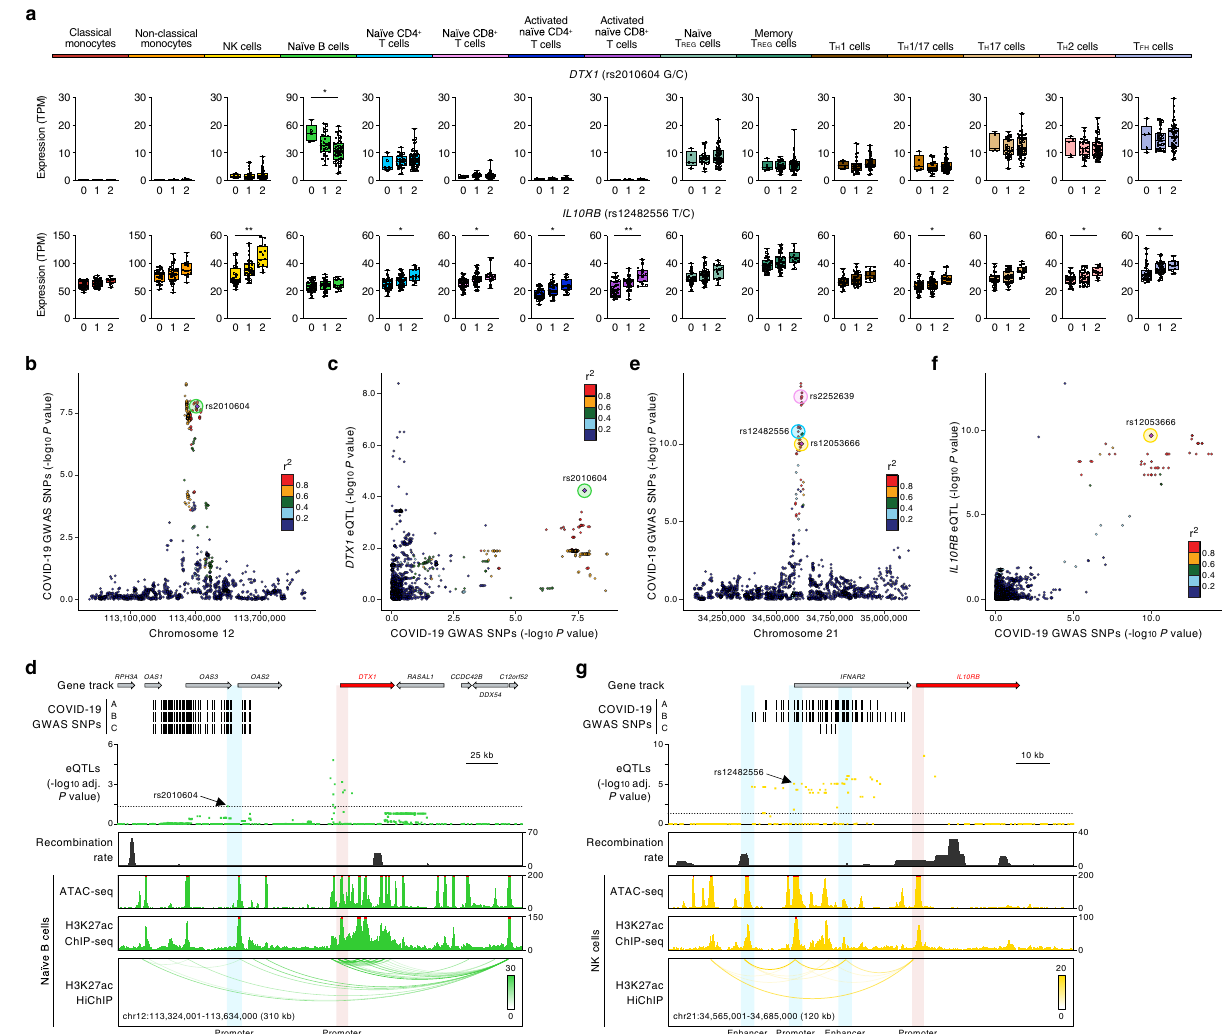
Fig. 3 Cell type-restricted effects of COVID-19-risk variants. a Mean expression levels (TPM) of severe COVID-19-risk-associated GWAS eGenes DTX1 and IL10RB in the indicated cell types from subjects ( n = 91) categorized based on the genotype at the indicated GWAS cis -eQTL; each symbol represents an individual subject; adj. association P value * P < 0.05, ** P < 0.001, and *** P < 0.00001. The boxplots show the 25th percentile, median, and 75th percentile, with the whiskers indicating the minimum and maximum values. b Plot shows GWAS association P value for COVID-19-risk variants in the indicated locus; the colocalized variant for DTX1 in naive B cells (rs2010604, green circle) is highlighted. c Locus compares plots 63 for DTX1 in naive B cells. Each variant is plotted to represent its -log 10 COVID-19 GWAS association P value ( x axis) and the − log 10 association P value for cis -eQTLs associated with the expression of DTX1 ( y axis). The colors denote the strength of linkage disequilibrium (LD) with the indicated lead SNP from the colocalization analysis (purple diamond). d WashU Epigenome Browser tracks for the DTX1 locus, COVID-19-risk-associated GWAS variants (based on respective GWAS meta- analyses, see Supplementary Fig. 1a), adj. association P values for cis -eQTLs associated with expression of DTX1 in naive B cells, recombination rate tracks 64,65 , ATAC-seq tracks, H3K27ac ChIP-seq tracks, and H3K27ac HiChIP-based chromatin-interactions in naive B cells. e Plot shows GWAS association P value for COVID-19-risk variants in the indicated locus; the colocalized variants for IL10RB in NK cells (rs12053666, yellow circle), and IFNAR2 in naive CD4 + T cells (rs12482556, blue circle) and naive CD8 + T cells (rs2252639, pink circle) are highlighted. f Locus compares plots 63 for IL10RB in NK cells. Each variant is plotted to represent its − log 10 COVID-19 GWAS P value ( x axis) and the − log 10 association P value for cis -eQTLs associated with the expression of IL10RB ( y axis). The colors denote the strength of linkage disequilibrium (LD) with the indicated lead SNP from the colocalization analysis (purple diamond). g WashU Epigenome Browser tracks for the IL10RB locus, COVID-19-risk-associated GWAS variants (based on respective GWAS meta- analyses, see Supplementary Fig. 1a), adj. association P values for cis -eQTLs associated with expression of IL10RB in NK cells, recombination rate tracks 64,65 , ATAC-seq tracks, H3K27ac ChIP-seq tracks, and H3K27ac HiChIP-based chromatin-interactions in NK